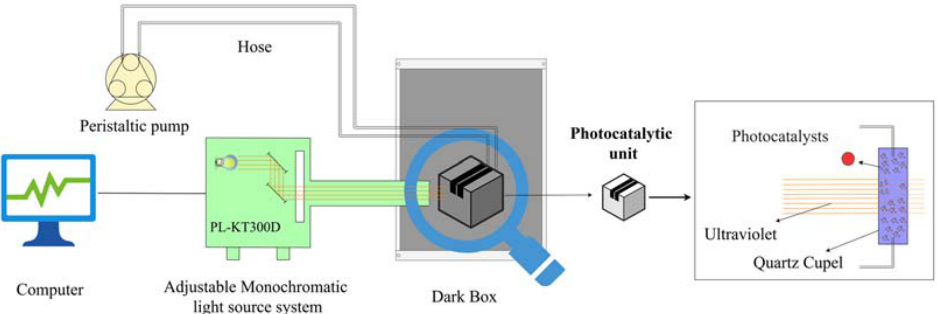
Figure 1. Flow chart of the photocatalytic reaction